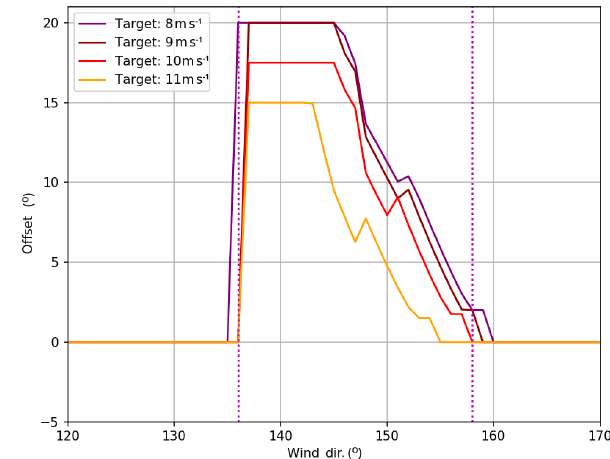
Figure 4. Target offset for 8, 9, 10 and 11ms − 1 . The red line indi- cates the target offset by wind direction. The magenta vertical lines indicate the approximate boundaries of the experiment (these vary slightly by wind speed, but the overall shape is the